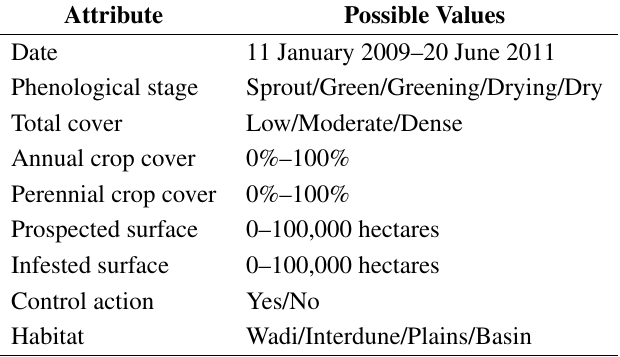
Table 1. RAMSES database fields and corresponding